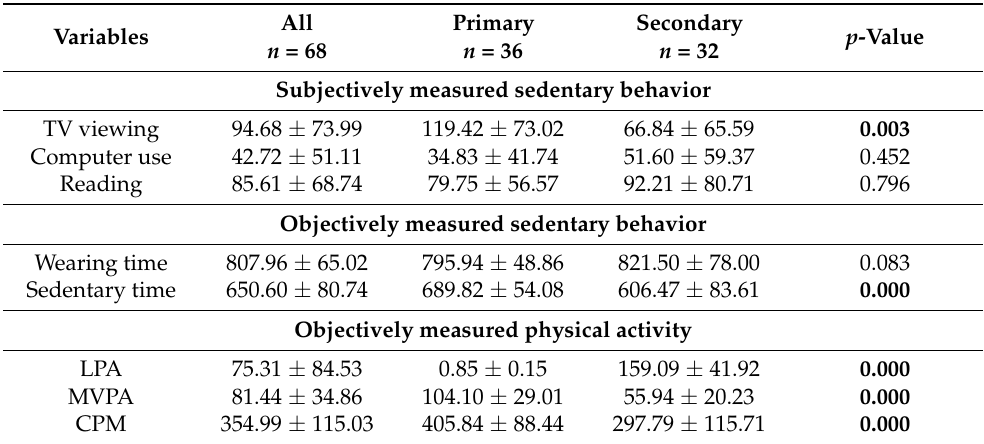
Table 2. Patterns of sedentary behavior and physical activity (minutes/day) throughout the week in youths with autistic spectrum disorder